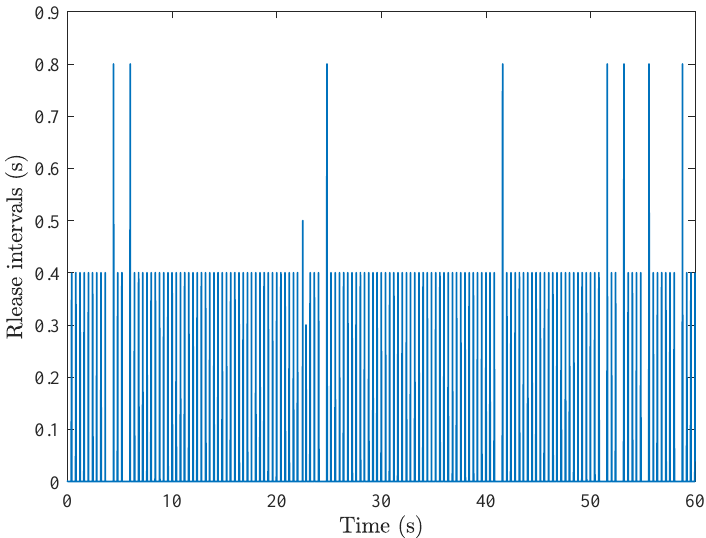
Figure 8. Event-triggered instants of sensor